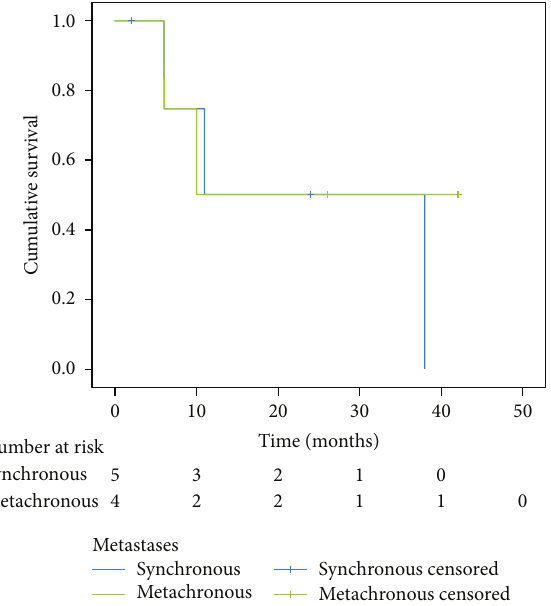
Figure5:Kaplan-Meiersurvivalcurveofsubgroupsofsynchronous and metachronous metastases; 𝑃 = 0,711